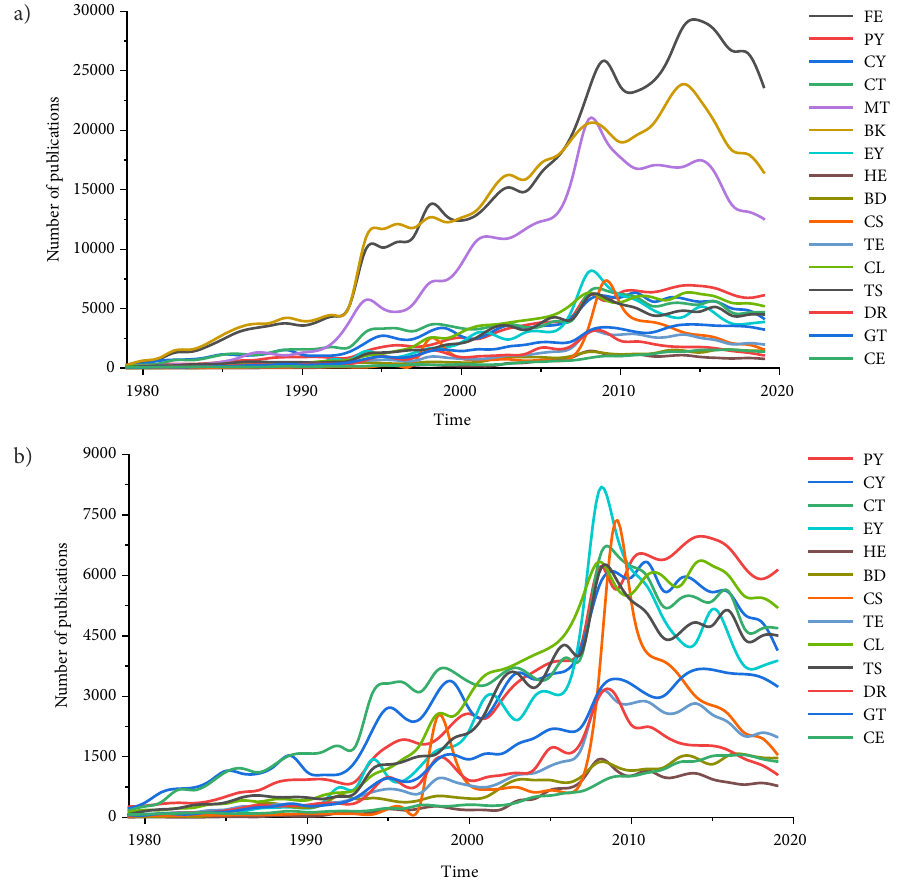
Figure 3. Chronological distribution of journal articles from 1979 to 2019 (source: authors’